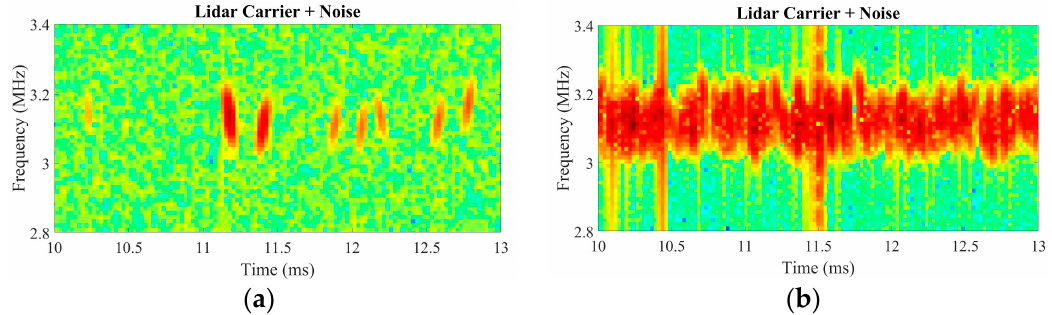
Figure 5. ( a ) Spectrogram of simulated lidar data for several scatterers crossing the beam. At any instant, during this short (~3 ms) simulation, the number of scatterers significantly illuminated within the probe volume is either 0 or 1; ( b ) Spectrogram of simulated lidar data (same duration ~3 ms) for a larger density of scatterers crossing the beam. At any instant, it is likely that several scatterers (N > 1) are significantly illuminated. The scatterers are given small random Doppler shifts to simulate slightly oblique paths across the beam. As usual with spectrograms there are smearing and rippling effects, and compromises are needed to choose filters and block lengths.